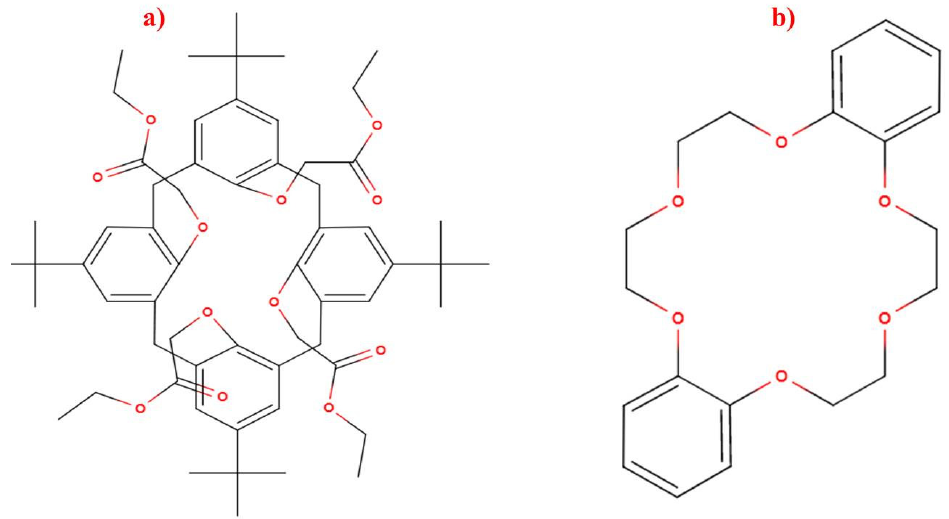
Figure 1. Structures of (a) tetraethyl 4-tert-butylcalix[4]arene (TBC) and (b) dibenzo-18-crown-6 (DC).